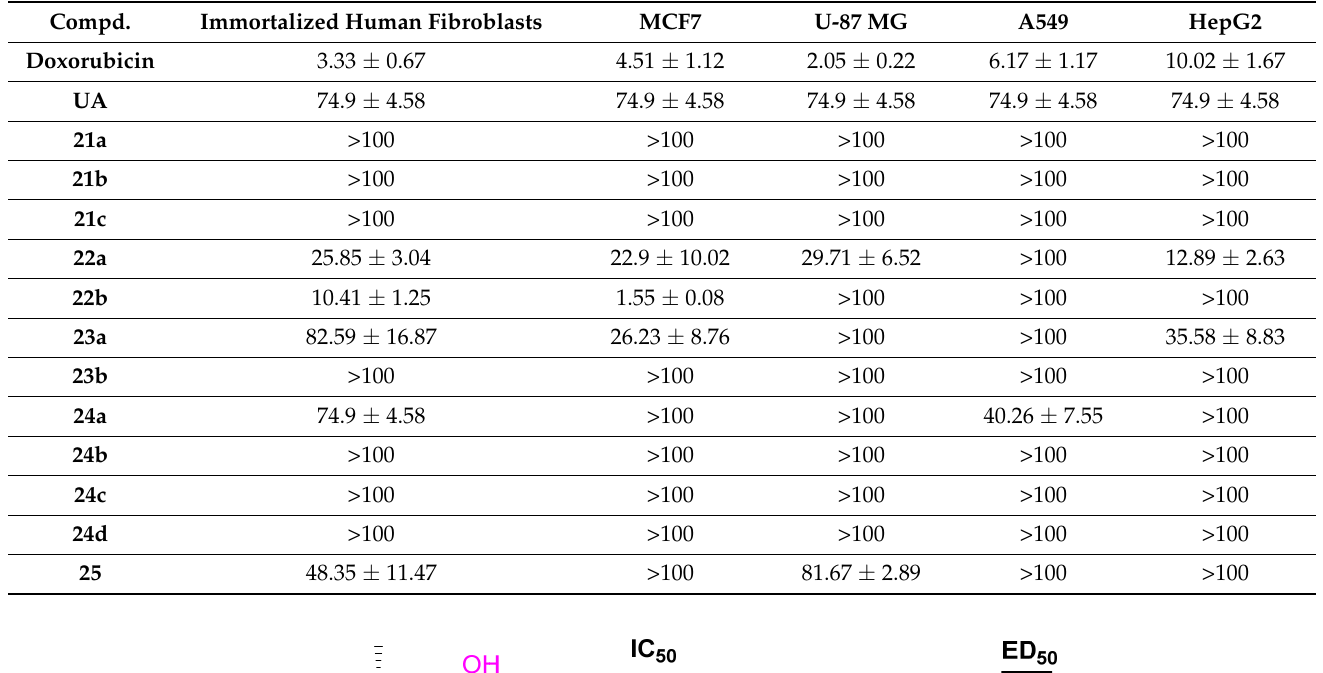
Table 3. Concentrations of the half-maximal inhibition (IC50 ± SEM, µ M) of compounds 21 – 25 on immortalized human fibroblasts, MCF7, U-87 MG, A549, HepG2 cells. Compd.